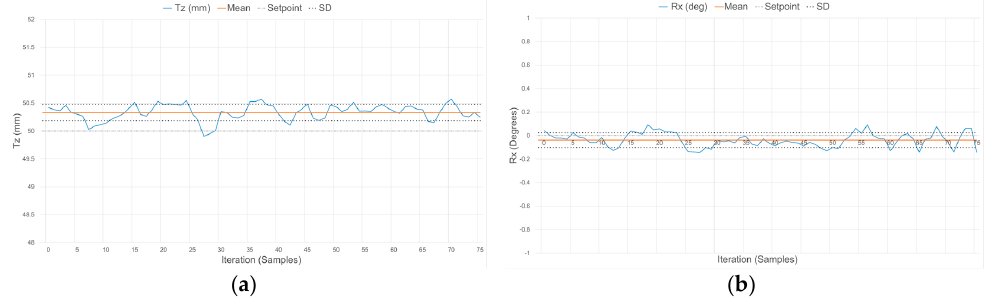
Figure 23. Response of the compliant wrist operating in proximity mode while measuring: ( a ) distance to; and ( b ) relative orientation of a fixed planar surface placed at 50 mm in front of the wrist and perpendicular to its main aiming direction (0°).